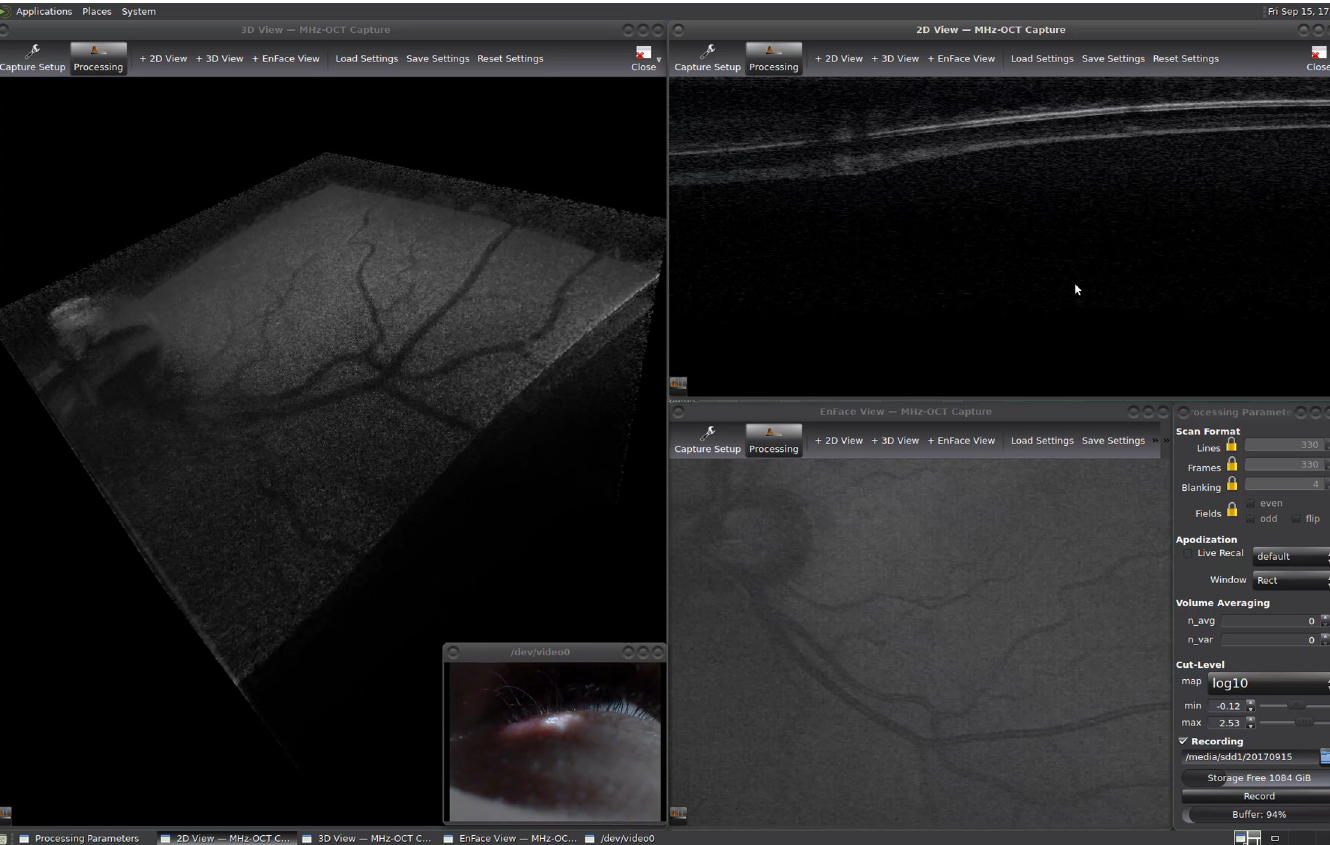
Fig 6. Screen capture recording of live retinal OCT imaging with 330 × 330 × 600 voxels at 24.2 Hz volume rate corresponding to 1.58 GVoxel/s (S7 Video). The left window shows the live rendered 3D volume with a size of 7.5x7.5x4.7mm and a webcam stream of the volunteer’s eye in the bottom right corner. On the right side, there is an en face projection (average of the whole volume), a three times averaged B-scan and the program control panel. All images are displayed in a logarithmic scale. A 3D- video in side-by-side format of the imaging session is available in S8 Video.